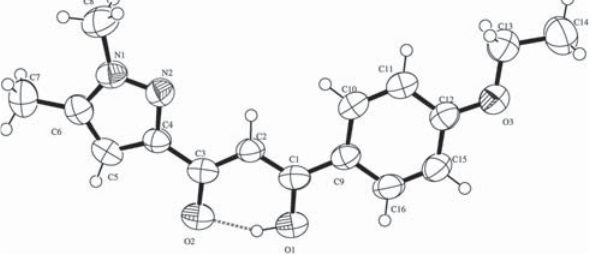
Table 1: Data collection and